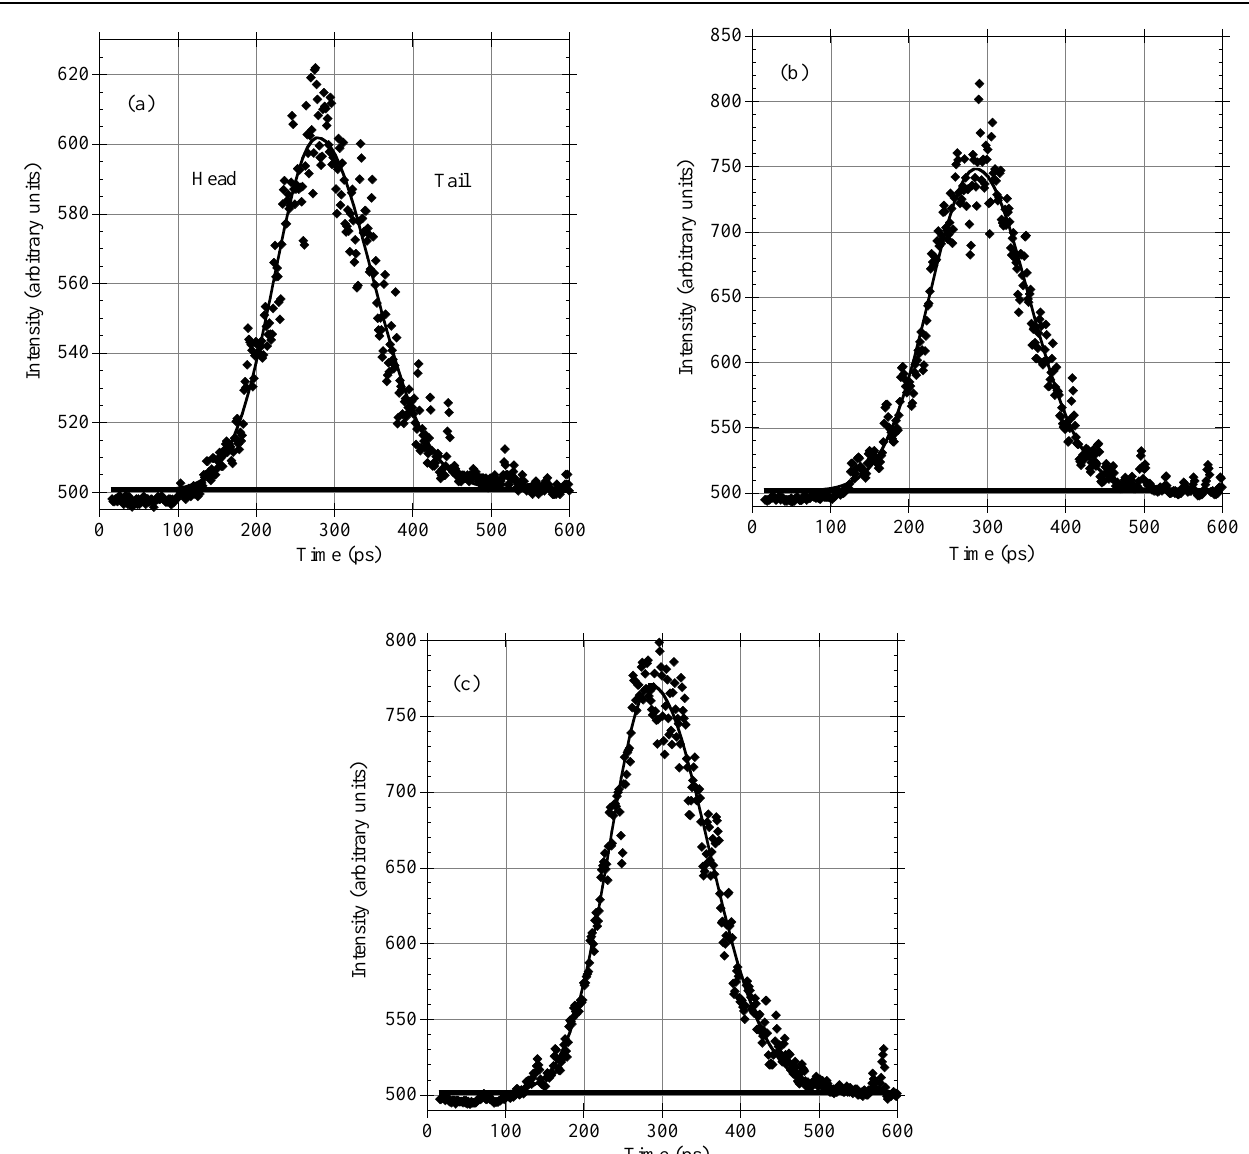
FIG. 6. A single data acquisition of the electron longitudinal bunch distribution at the current settings of (a) 1.3 mA per bunch, (b) 6.0 mA per bunch, and (c) 12.5 mA per bunch. As denoted in (a), the head of the distribution is to the left of the center and the tail of the distribution is to the right of the center of the